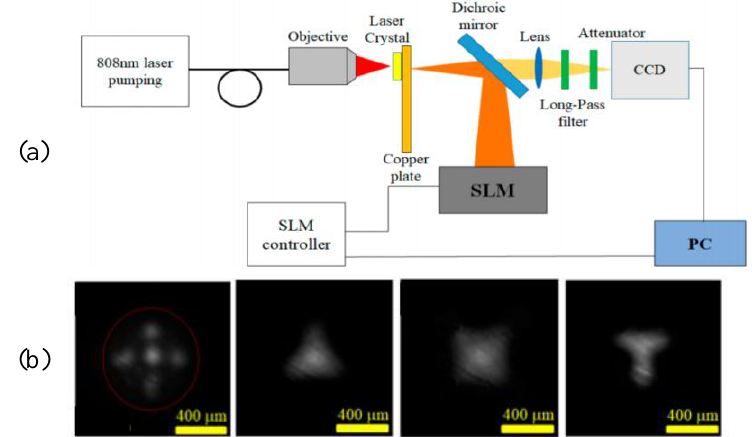
Figure 5. ( a ) The laser that generates the laser beam of controllable intensity profiles and ( b ) the resulting field of discrete points, triangle, rectangular and ‘T’ shape field distributions (Adapted from an open-access source Ref.